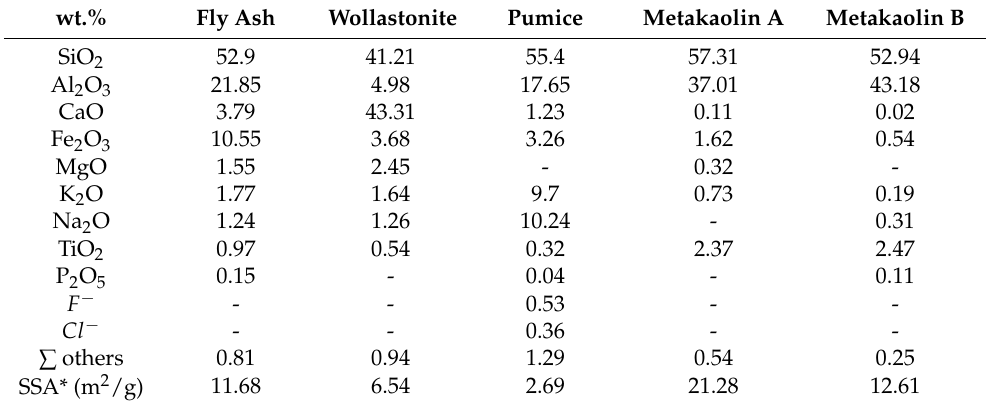
Table 1. Chemical composition and specific surface area of filler